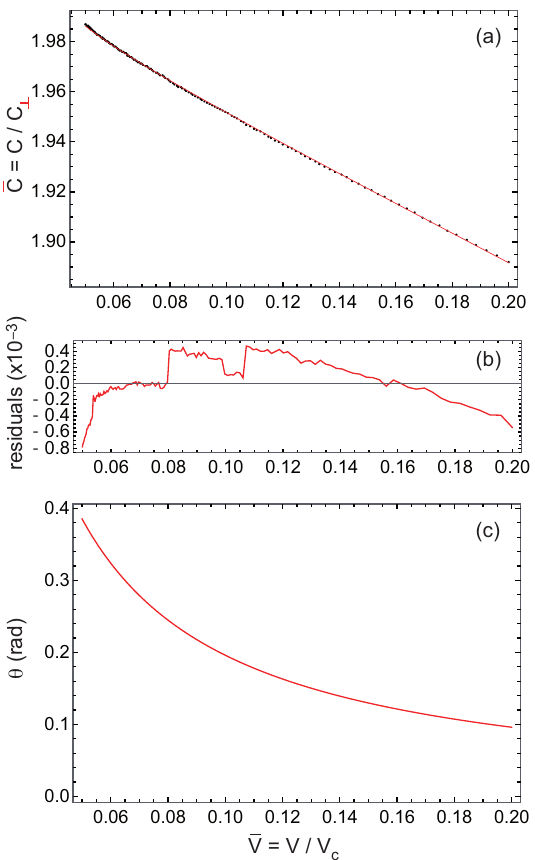
Figure 9. ( a ) Capacitance curve measured at T = 40 ◦ C (the dots are the experimental points) and its fit (solid line) obtained by taking into account the variation with electric field of ε (cid:107) . The best fit is obtained by taking κ = − 0.08 and L = 0.0293 µ m. ( b ) Residuals. ( c ) Angle θ on the plates as a function of the voltage.